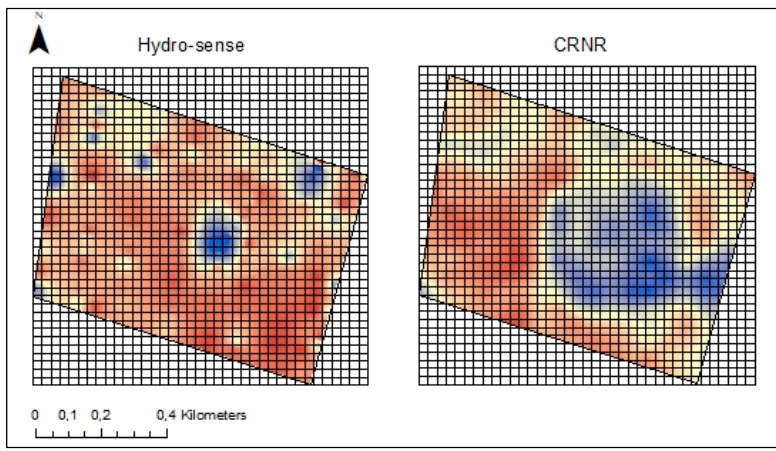
Figure 10. Illustration of the fishnet grid on the Pine (survey four) hydro-sense and CRNR maps. First, the descriptive statistics were determined for each dataset. From Table 3, the hydro-sense and corresponding CRNR survey mean values are similar. The range, standard error, kurtosis, skewness and standard deviation of the hydro-sense values are generally larger than the corresponding CRNR values. Table 3. Descriptive statistics of the hydro-sense and CRNR soil water maps.